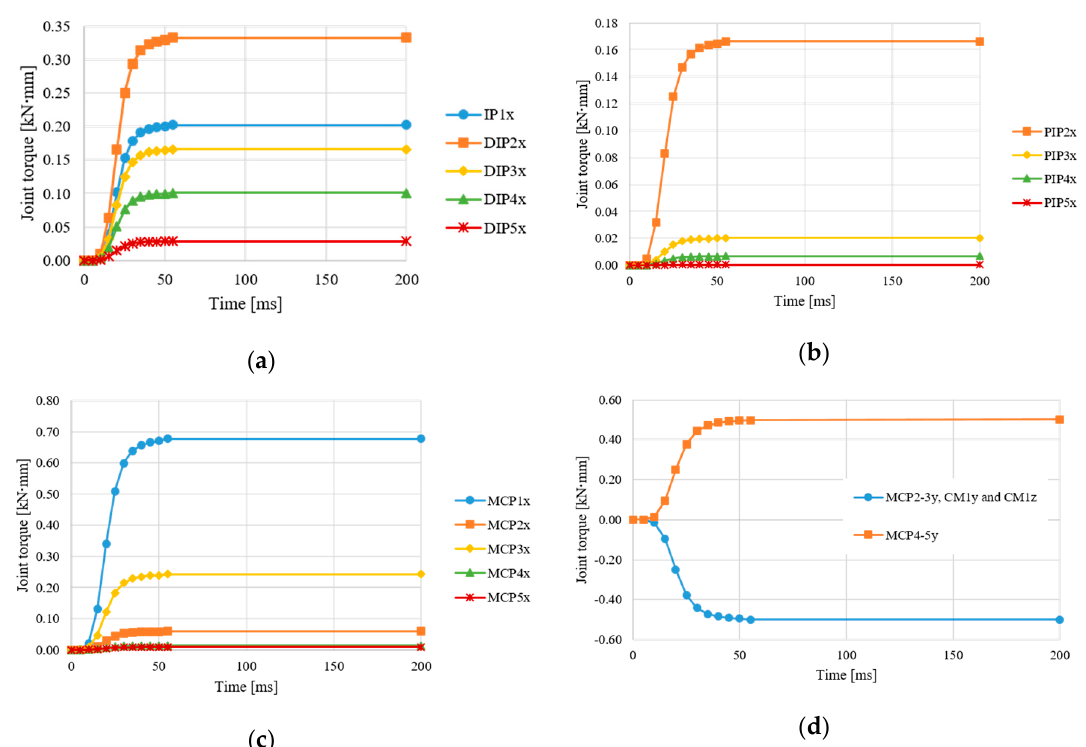
Figure 6. Joint torques inputted into the joints of the hand FE model. ( a ) IP1x and DIP2x to DIP5x joints. ( b ) PIP2x to PIP5x joints. ( c ) MCP1x to MCP5x joints. ( d ) MCP2y to MCP5y, CM1y and CM1z joints.